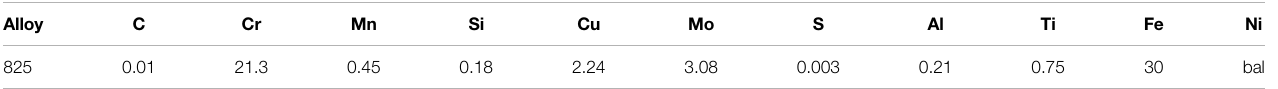
Frontiers in Materials |